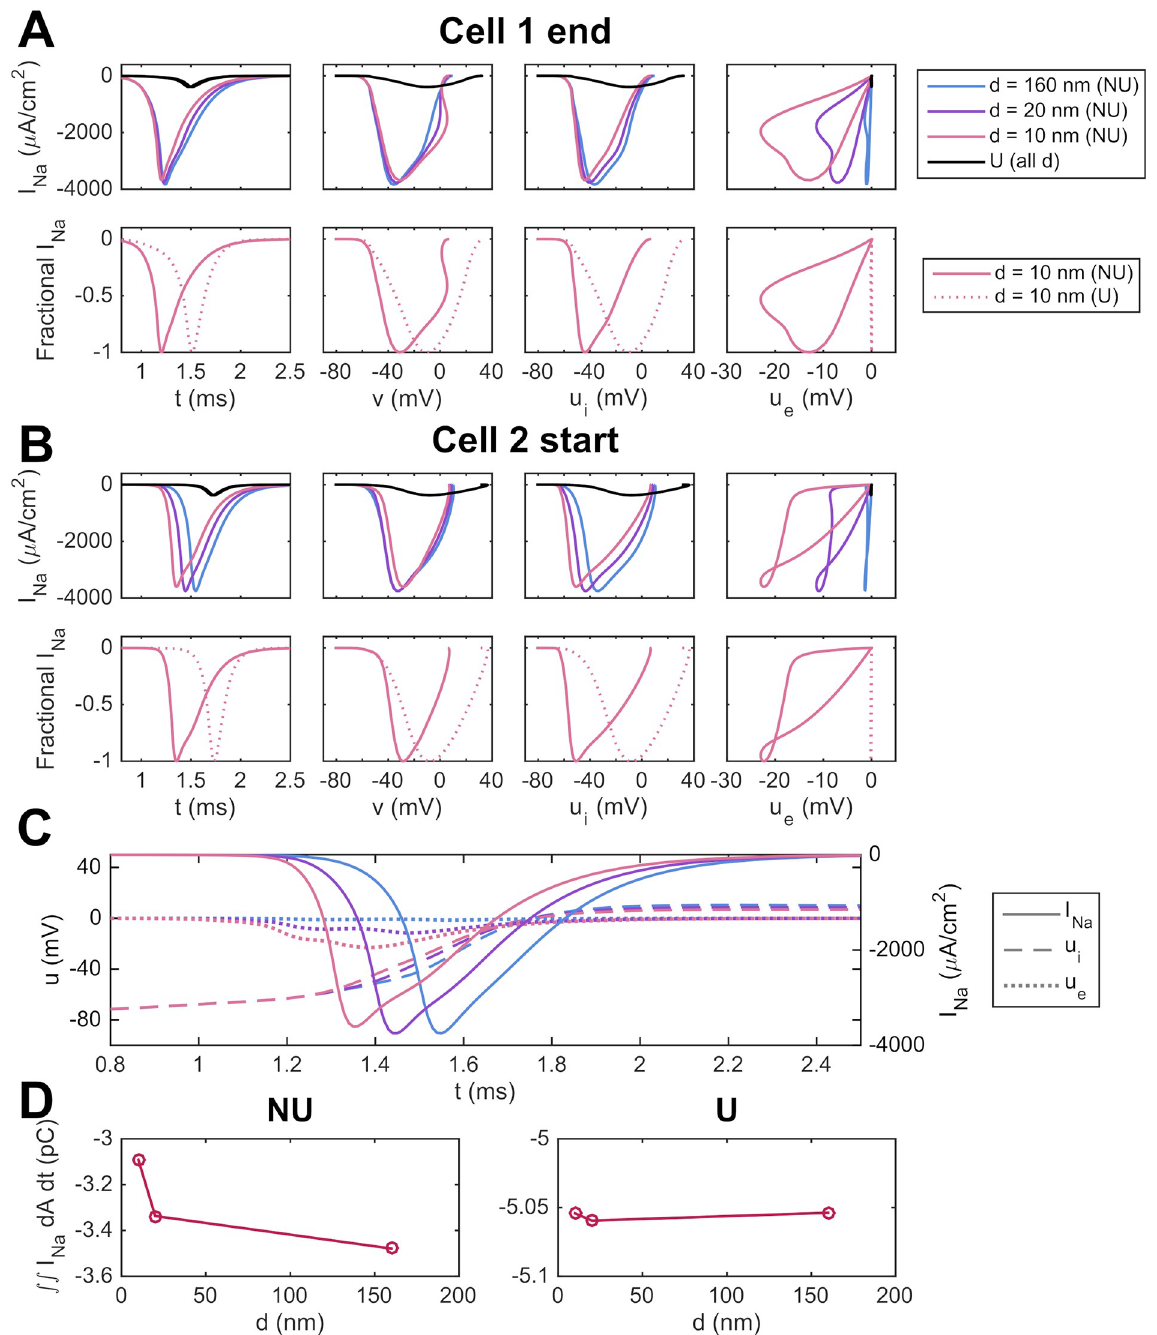
Fig 16. The activation dynamics of I Na are affected by the sodium channel distribution and cell distance. (A) Raw (top panels) and normalized (fraction of peak, bottom panels) I Na currents for the distal cell-end membrane in the first cell of a two-cell strand. I Na in this membrane region is shown at each of three different cell distances ( d = 5 nm, 10 nm, 160 nm) for the U and NU cases. (B) Similar results for the membrane at the beginning of the second cell. (C) Time development of I Na , u whole-cell I Na influx in the second cell over the entire upstroke for the NU and U cases. The simulation set up and parameters are the same as in Fig 14, except that the gap junction resistance is set to the default value of Table 1.